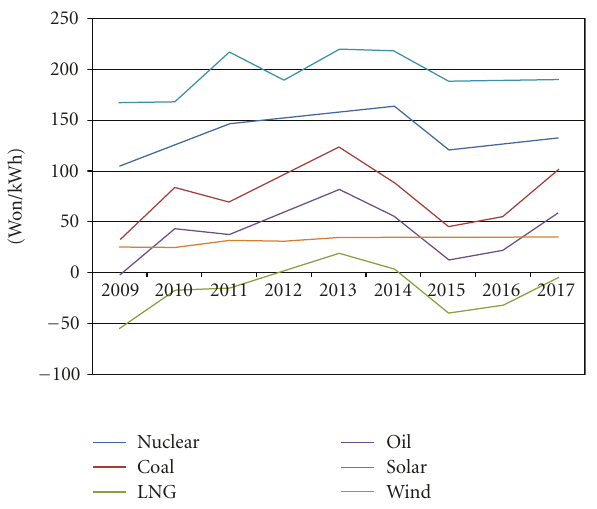
Figure 29: Profitability on each energy resource.